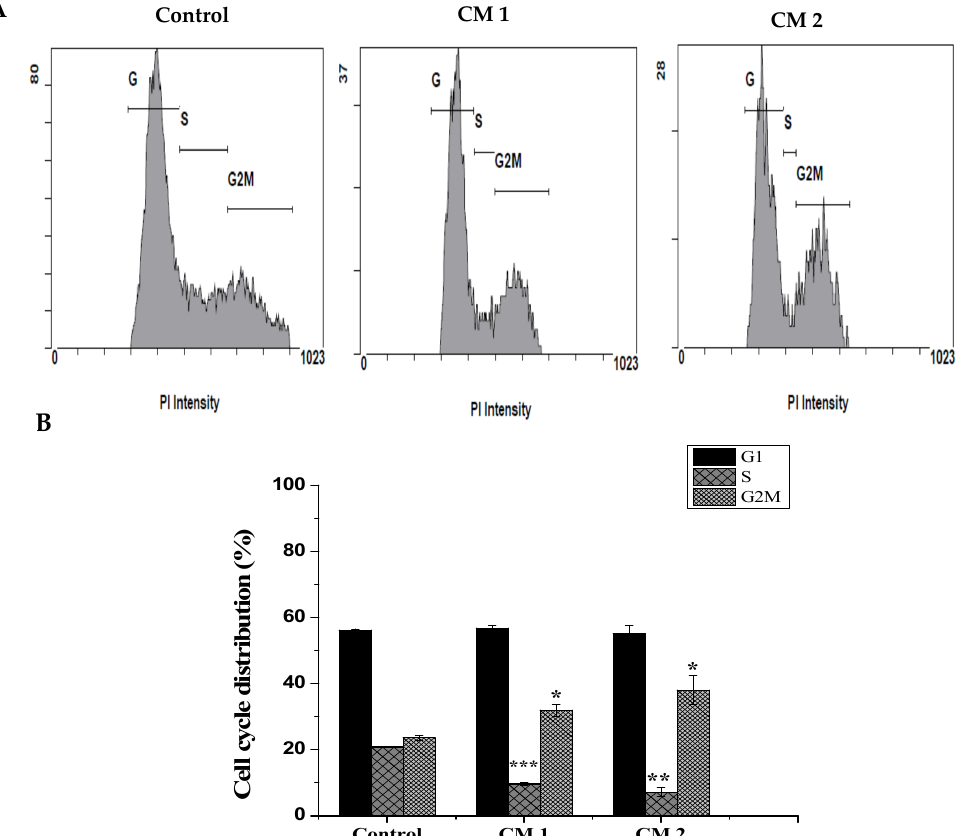
Figure 3. Compounds CM1 and CM2 induced cell cycle arrest. HepG2 cells were exposed to the IC 50 for 48 h and analysis was determined as described. ( A ) Distribution of cell phases after treatment with compounds CM1 and CM2. ( B ) Quantitative analysis of data obtained. Data represented as the mean ± SD (n = 3). (*P < 0.05, **P < 0.01, ***P < 0.001 vs. control)